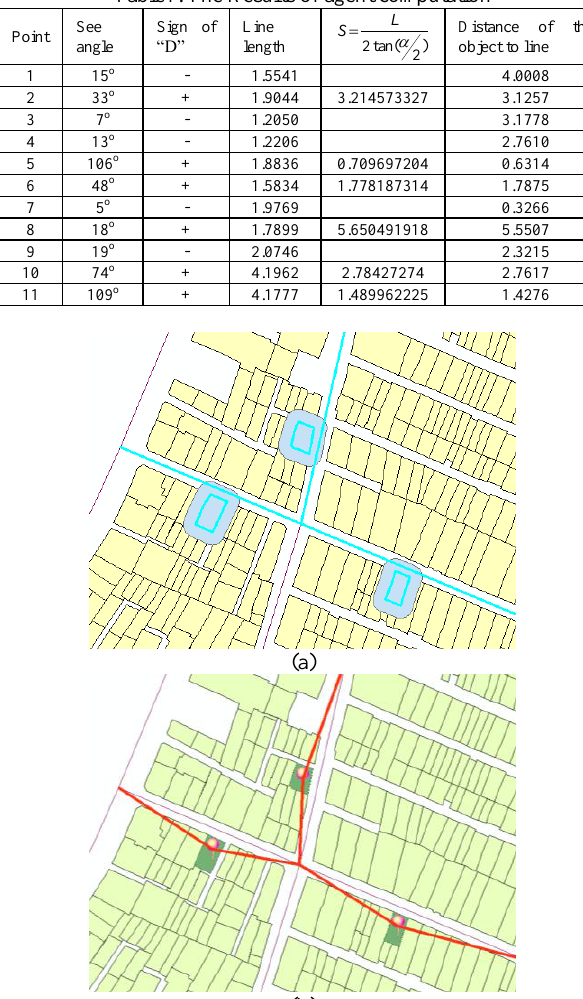
Figure7. The comparison of (a) common buffer operator and (b) Agent-based line